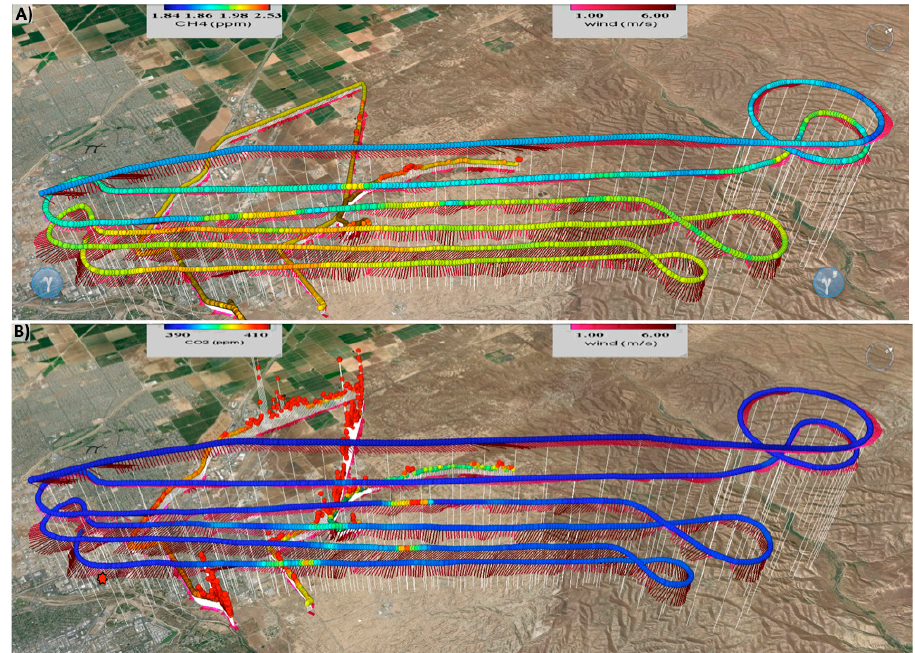
Figure A1. ( A ) Methane (CH 4 ) and ( B ) carbon dioxide (CO 2 ), and winds for 4 September 2014 from airborne in situ (CIRPAS) and surface mobile in situ (AMOG surveyor). Red star shows data curtain zero point (119.0411°W, 35.3972°N). Data keys on panels.